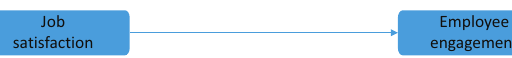
capital FIGURE 6: Conceptual and research framework 2.